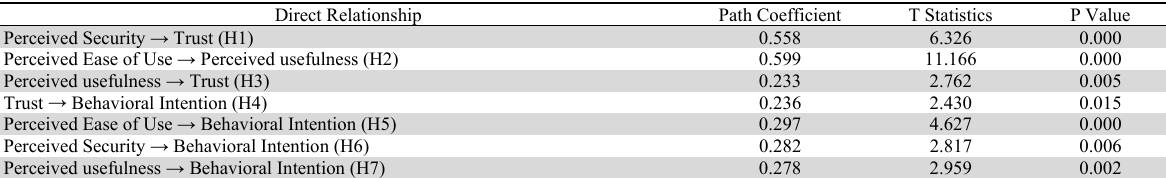
Direct Path Coefficient and T statistics